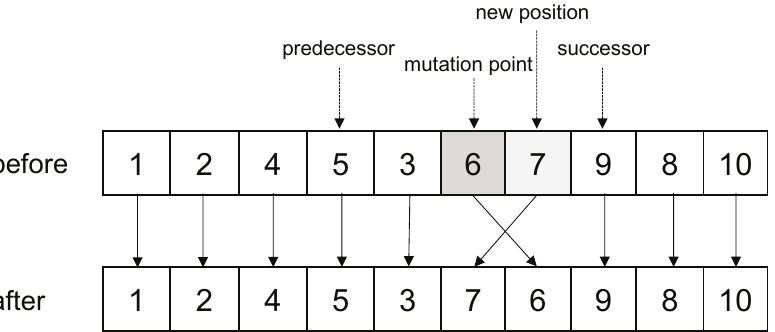
Figure 6. Mutation